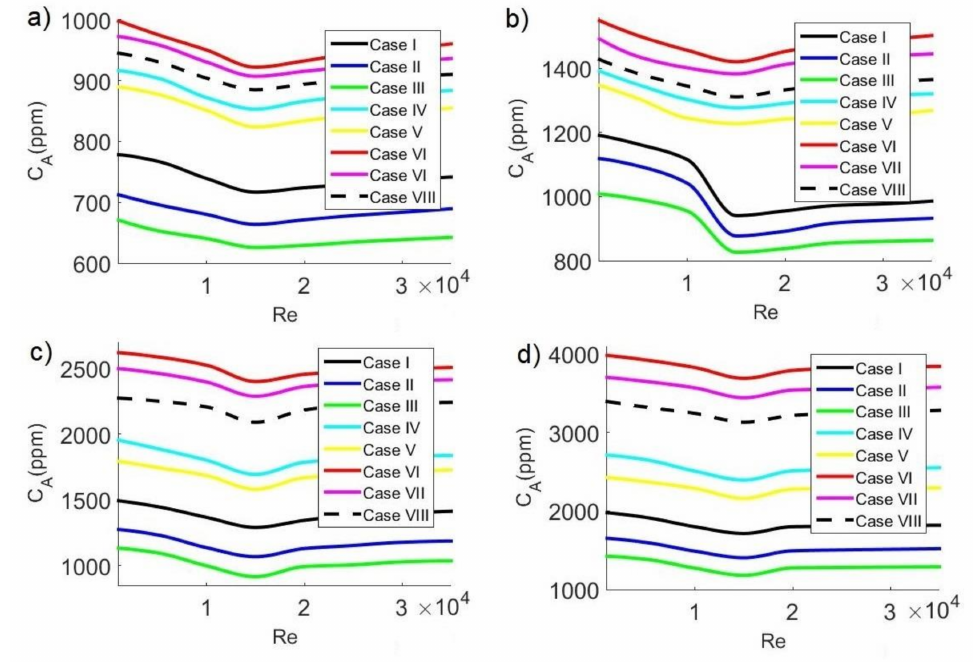
Figure 11. Average concentration of CO 2 in the classroom as a function of Reynolds number at 3:30 p.m. with CO 2 sources of: ( a ) 35,000 ppm; ( b ) 37,500 ppm; ( c ) 40,000 ppm; ( d ) 42,500